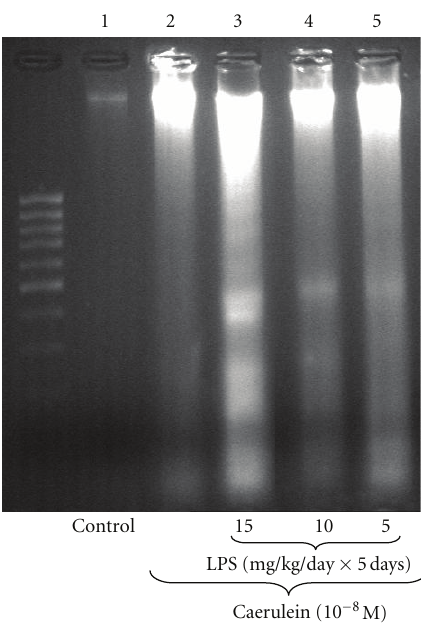
Figure 7: Analysis of DNA fragmentation pattern in the adult rat pancreatic acinar cells under basal conditions (lane 1), stimulated in vitro by caerulein at the dose of 10 − 8 M (lane 2), treated in the infant animals by lipopolysaccharide ( Escherichia coli ) at the doses of 15 mg/kg/day × 5 days + caerulein 10 − 8 M (lane 3), 10mg/kg/day × 5 days + caerulein 10 − 8 M (lane 4), and 5mg/kg/day × 5 days + caerulein 10 − 8 M (lane 5) after 5 hours of incubation. All presented results were obtained in 4 consecutive experiments and are representative of the observed